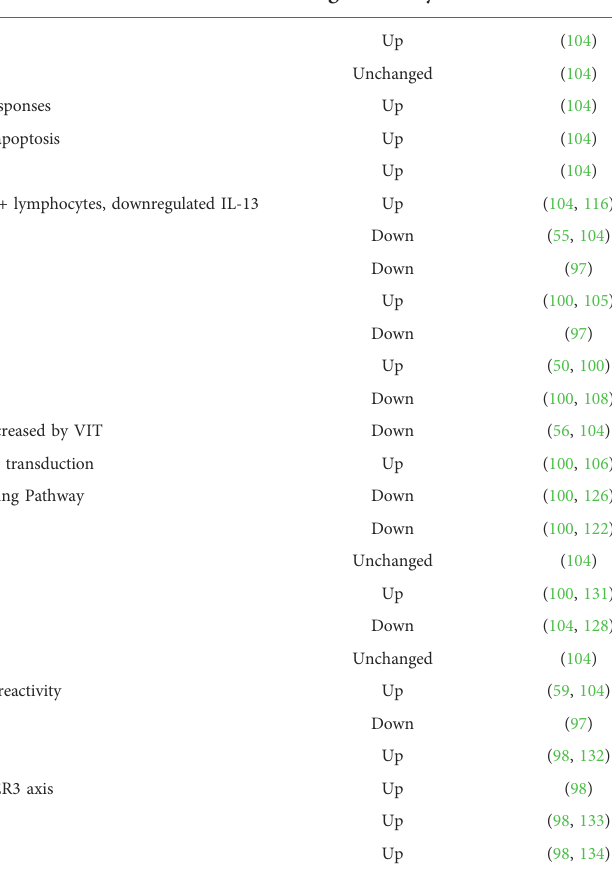
TABLE 2 Micro-RNAs involved in pathogenic mechanisms of allergen immunotherapy.